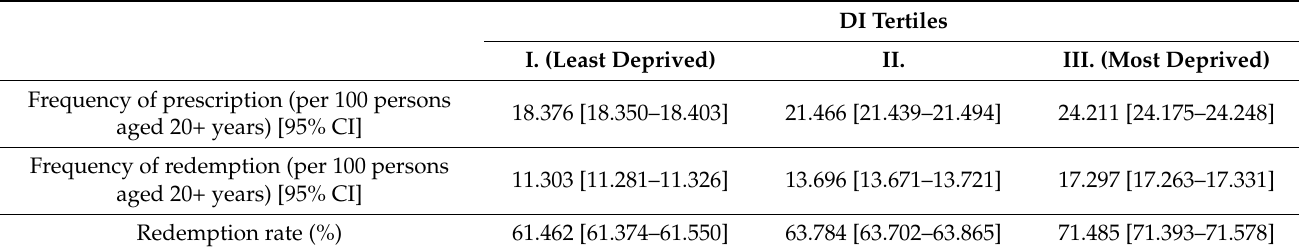
Table 3. Frequency of prescription, redemption, and relative redemption rate of metformin by deprivation tertiles at district level, in Hungary,